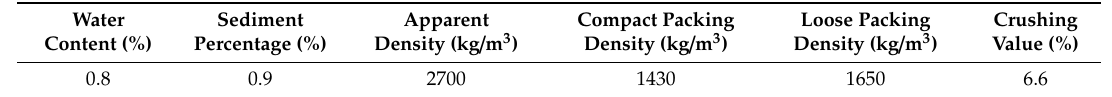
Table 3. Properties of the natural stone.